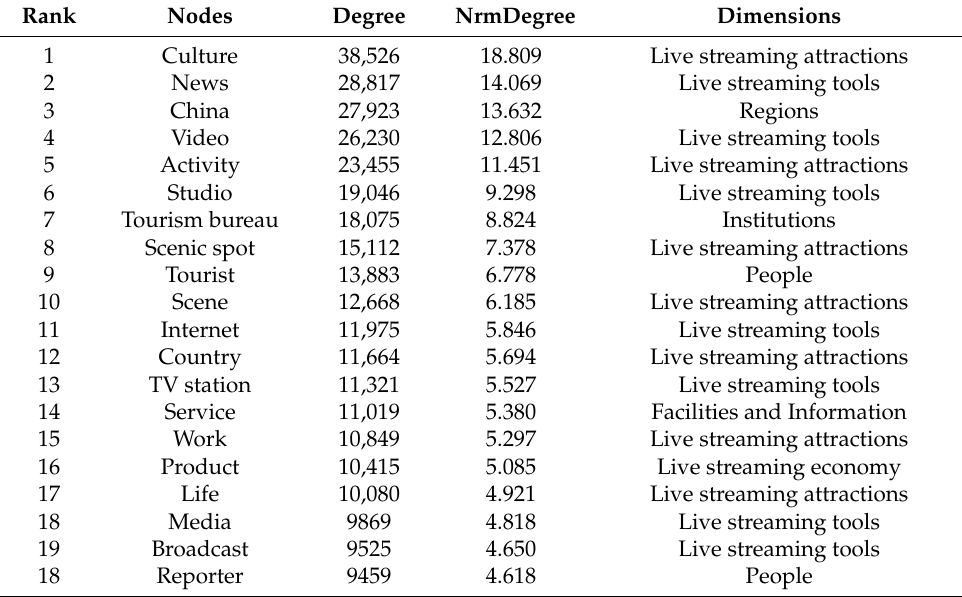
Table 2. Degree centrality analysis of tourism live streaming.